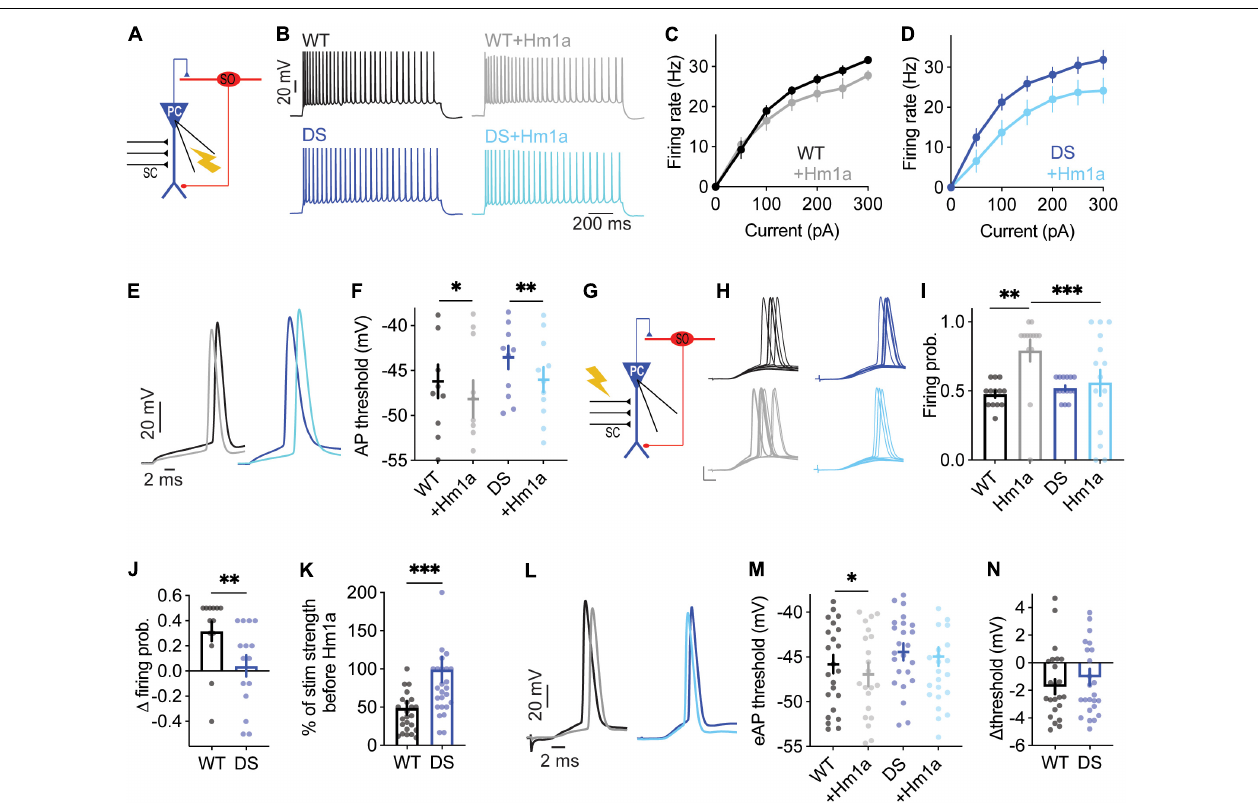
FIGURE 2 | Reduced evoked synaptic response of DS Scn1a A1783V / WT CA1 pyramidal neurons to Hm1a application. (A) Illustration of the recording configuration. Neuronal firing of CA1 pyramidal neurons (blue) was evoked by injection of depolarizing current through the patch pipette. (B) Representative traces of whole-cell current clamp recordings from CA1 pyramidal neurons in response to current injection of +150 pA, before and after Hm1a application. (C,D) The effect of Hm1a on firing in response to current injection through the whole-cell patch electrode in WT (C) and DS (D) CA1 pyramidal neurons. Statistical analysis utilized Mixed Model Analysis of Variance; (C) p = 0.08 for Hm1a treatment, p = 0.06 for current × treatment; (D) p = 0.07 for Hm1a treatment, p = 0.09 for current × treatment. (E) Representative WT and DS APs at rheobase, before and after Hm1a application. (F) The effect of Hm1a on AP threshold at rheobase current. Statistical analysis utilized Two Way Repeated Measures ANOVA. The markings on the graph depict the results of Bonferroni post hoc analysis: p = 0.30 for genotype; p < 0.001 ( ∗∗∗ ) for Hm1a treatment, and p = 0.58 for the interaction. The data in (C–F) included: WT: n = 11 cells from 4 mice; DS: n = 16 cells from 3 mice. (G) Schematic illustration of the SC stimulation and whole-cell recording of a CA1 pyramidal neuron. (H) Representative traces of WT and DS CA1 pyramidal neurons in response to a train of 10 stimuli at 1 Hz, delivered to the SC, with or without Hm1a. Scale bar = 20 mV, 5 ms. (I,J) The effect of Hm1a on the firing probability of WT and DS CA1 pyramidal neurons (I) , and the difference in firing probability calculated for each cell (J) . Statistical analysis for the data presented in I utilized Two Way Repeated Measures ANOVA. The markings depict the results of Bonferroni post hoc analysis: p = 0.036 ( ∗ ) for genotype; p = 0.070 for Hm1a treatment; p = 0.002 ( ∗∗ ) for the interaction. The Mann–Whitney test was used to analyze the data in (J) . (K) The effect of Hm1a on the stimulation intensity required to produce 50% firing probability. Statistical analysis utilized the Mann–Whitney test. (L–N) Representative traces of eAPs before and after Hm1a application (L) , the overall effect of Hm1a on the eAP threshold (M) , and the difference in eAP threshold (N) . Statistical analysis utilized Two Way Repeated Measures ANOVA. The markings depict the results of Bonferroni post hoc analysis: p = 0.3 for genotype; p = 0.019 ( ∗ ) for Hm1a treatment; p = 0.19 for the interaction. The data in (I–N) included WT: n = 25 cells from 9 mice; DS: n = 27 cells from 8